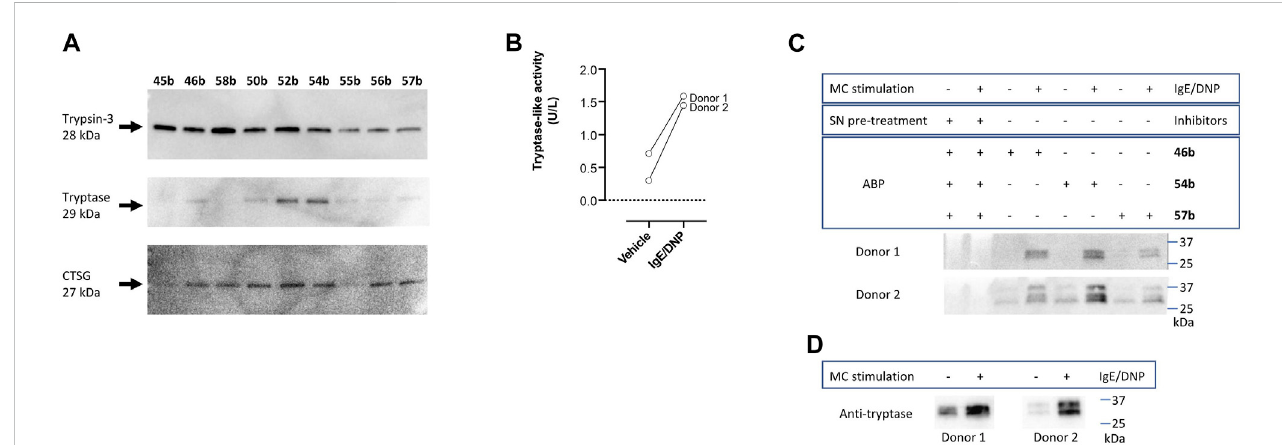
Validation of newly synthesized desthiobiotin probes for detection of trypsin-like proteases. (A) Labeling and detection of recombinant proteases in a SDS-PAGE-Blot. (B) Tryptase-like activity was measured from the stimulated mast cells of two donors by a spectrophotometric assay with a fl uorogenic substrate. IgE/DNP stimulated mast cells were used. The tryptase-like activity is expressed as U/L. (C) Labeling of mast cell supernatants and identi fi cation of proteases. (D) Detection of tryptase in mast cell supernatants with anti-mast cell tryptase antibody, visualized by Western